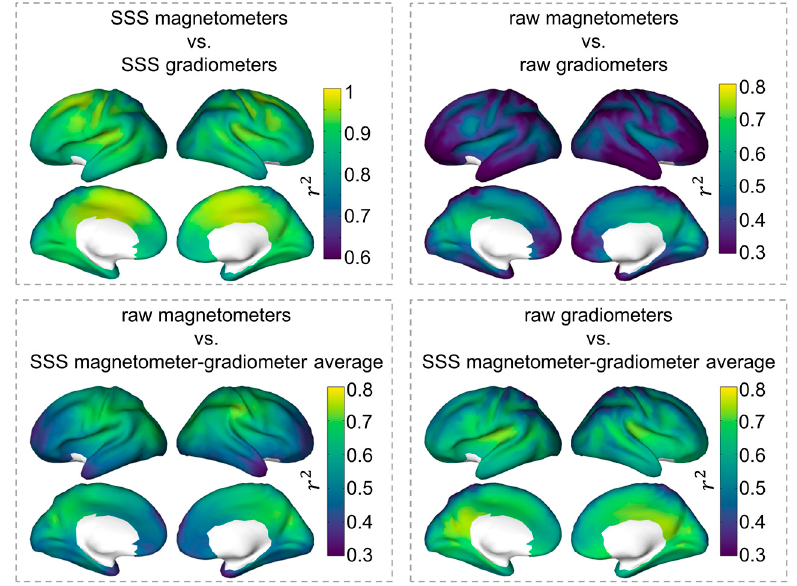
Figure 3. Correlation between source time series for λ mag = 0.01 and λ grad = 0.29. The brain surfaces display the subject-averaged squared Pearson correlation coefficients between pairs of source time series estimated with different sensor types and with/without SSS. Note that the limits of the color bars differ across panels.